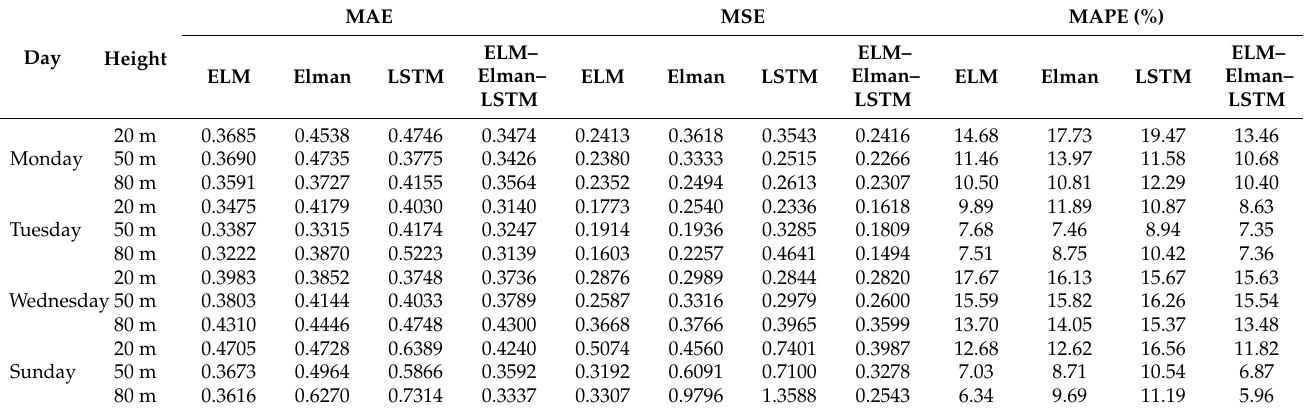
Table 5. The three evaluation indices value of the ELM–Elman–LSTM model and the single models.